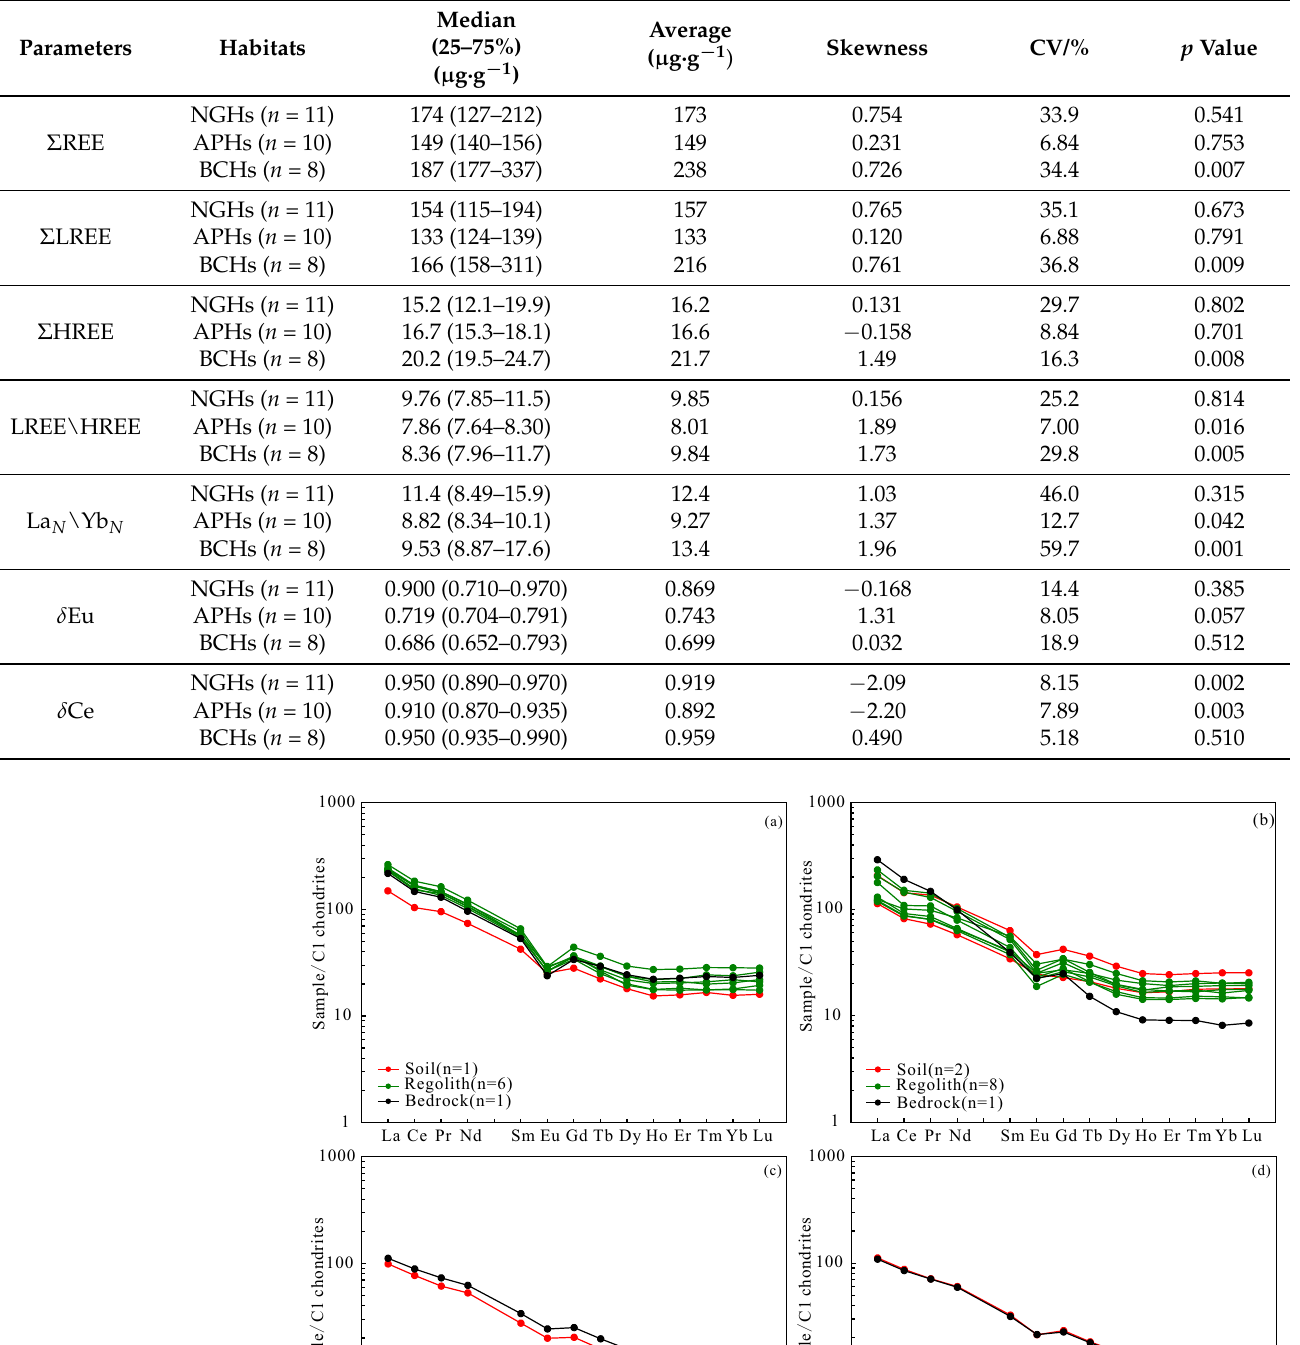
Table 1. Parameters on REE distribution characteristics of rhizosphere soils in various habitats, Hebei Province.